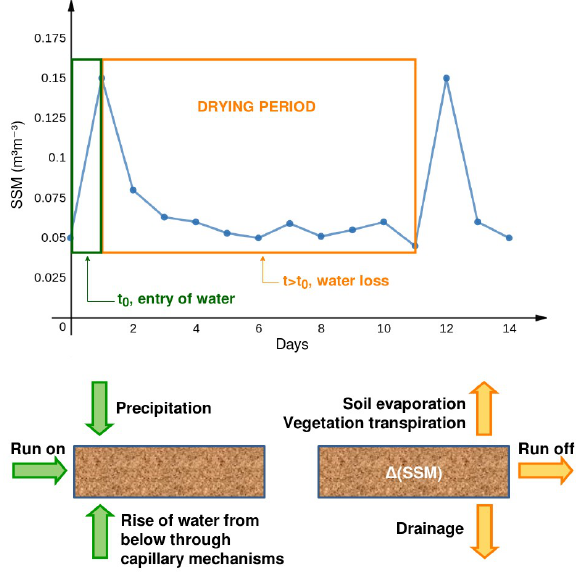
Figure 3. Illustration of the drying process of the soil: The drying period starts when there is an input of water (green arrows) which increases SSM, either by precipitation or run on, or more gradually, by capillary flow if water tables rise close enough to the surface. Drying (orange arrows) results from evapotranspiration, run off and drainage, modifying the SSM